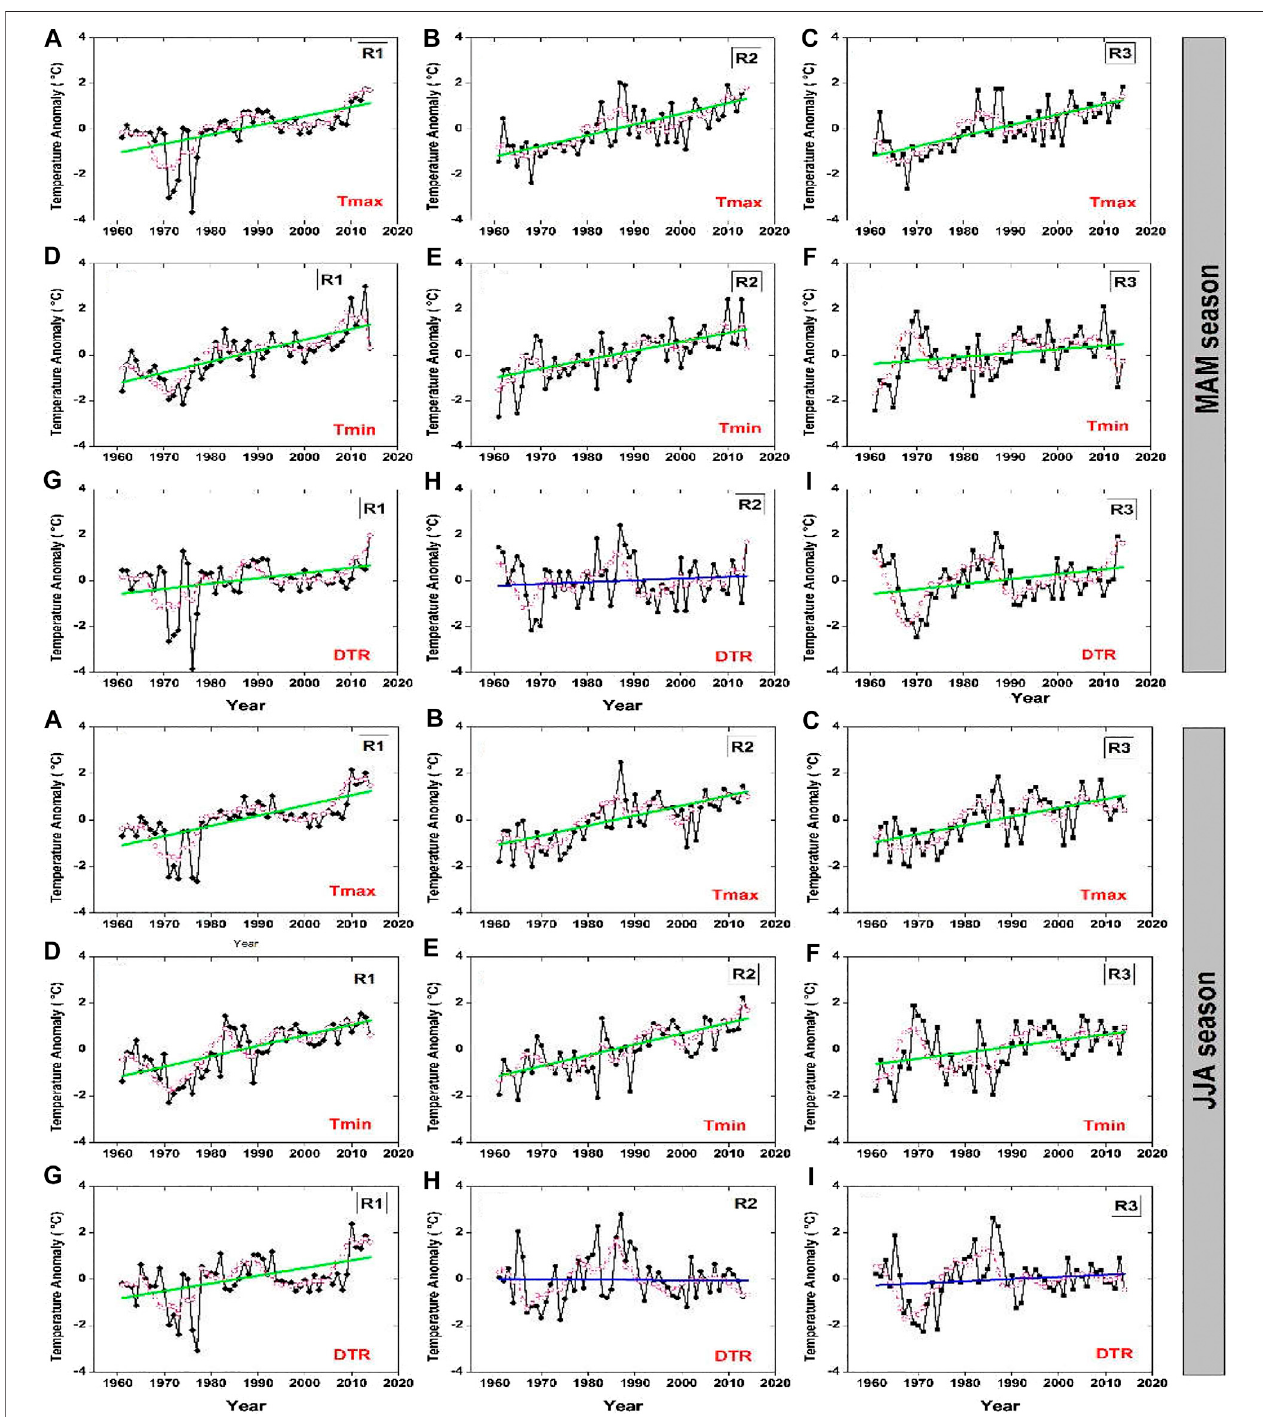
FIGURE3a| Five-yearmovingaverageofmonthly,seasonal(MAMandJJA)Maximum,MinimumandDiurnalTemperatureandtheirlinearTrendsforthreeregions (R1: 500 ≤ stations ≤ 1,500 m; R2:1,500 m ≤ stations ≤ 2,000 m; R3: stations ≥ 2,000 m) over the period of 1961 – 2014. Green line indicates signi fi cant raising while the blue line indicates a neutral or decreasing trend.